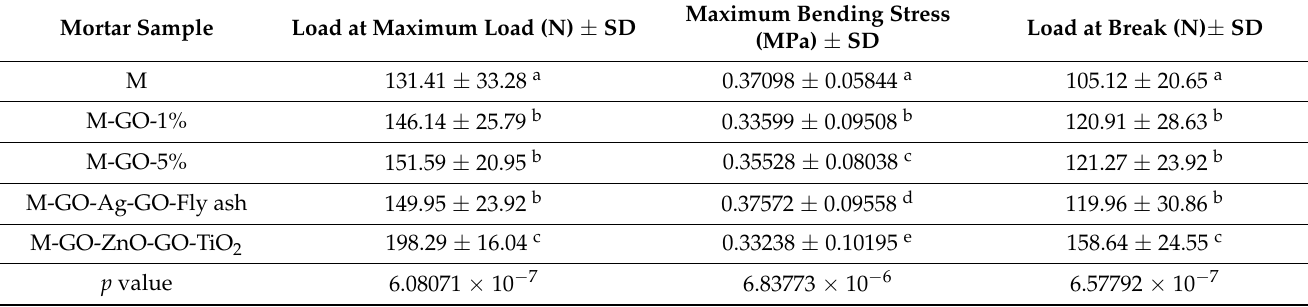
Table 4. Flexural test results (following the Tukey test: groups of specimens marked with the same letter show no statistically significant differences between them; the groups marked with different letters show statistically significant differences between